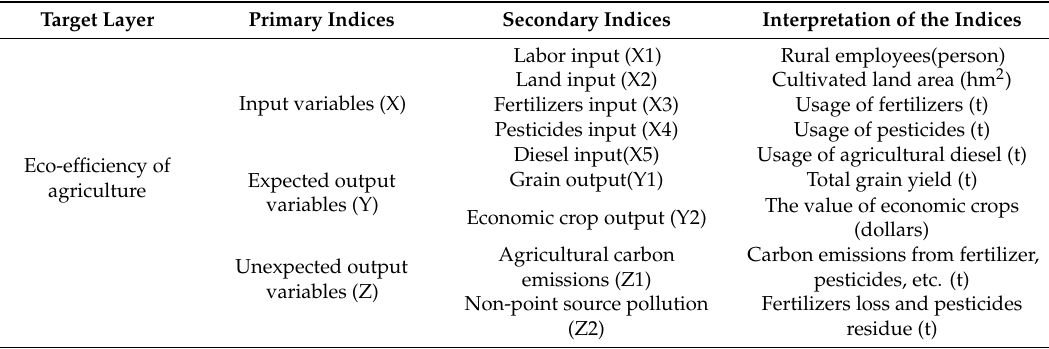
Table 1. Evaluation index system of agricultural eco-e ffi